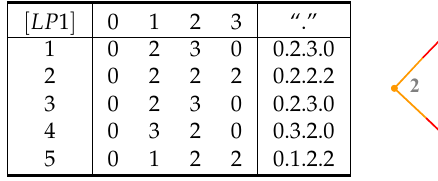
Figure 17. [ LP 1 ] on Figure